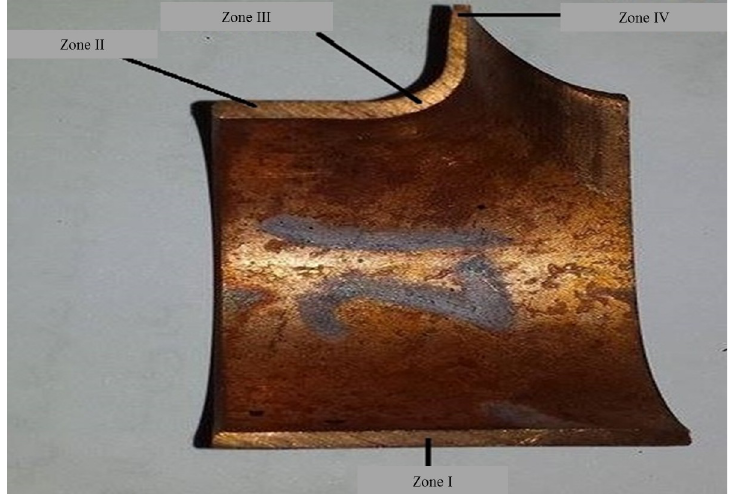
Fig 11. Cross-section of tube after